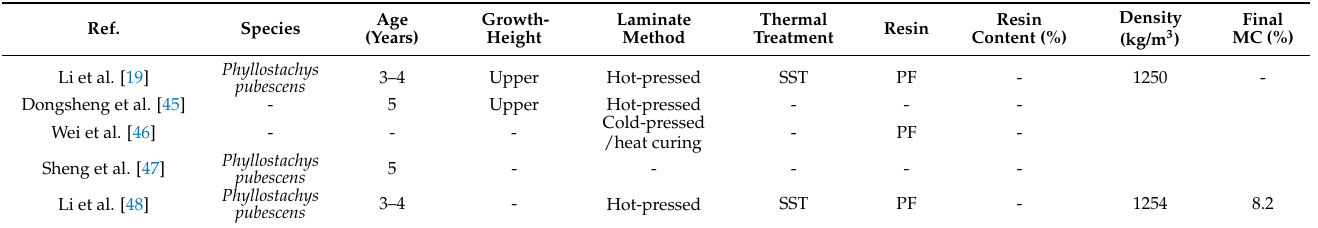
Table 1. Manufacturing parameters reported in the bamboo scrimber investigations.